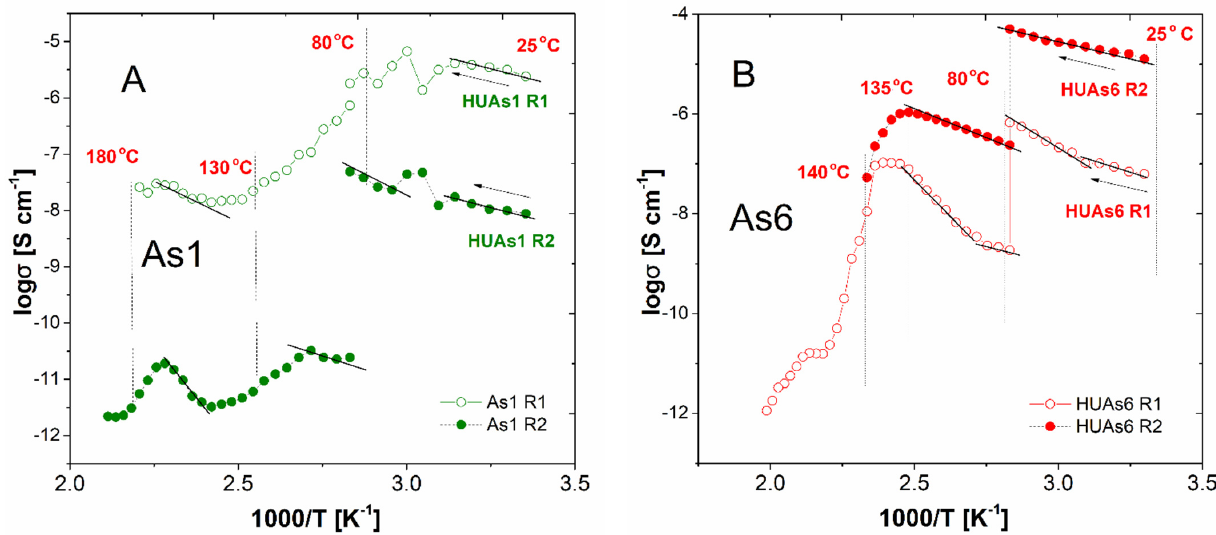
Figure 7. Exemplary Arrhenius type dependencies of R1 (empty symbols) and R2 (full symbols) related conductivities for: ( A )—As1 (90% Gm + 10% HUAs)) and ( B )—As6 (40% Gm + 60% HUAs) composite materials. Table 3. Immittance investigations derived charge transport parameters for the systems studied for R 1